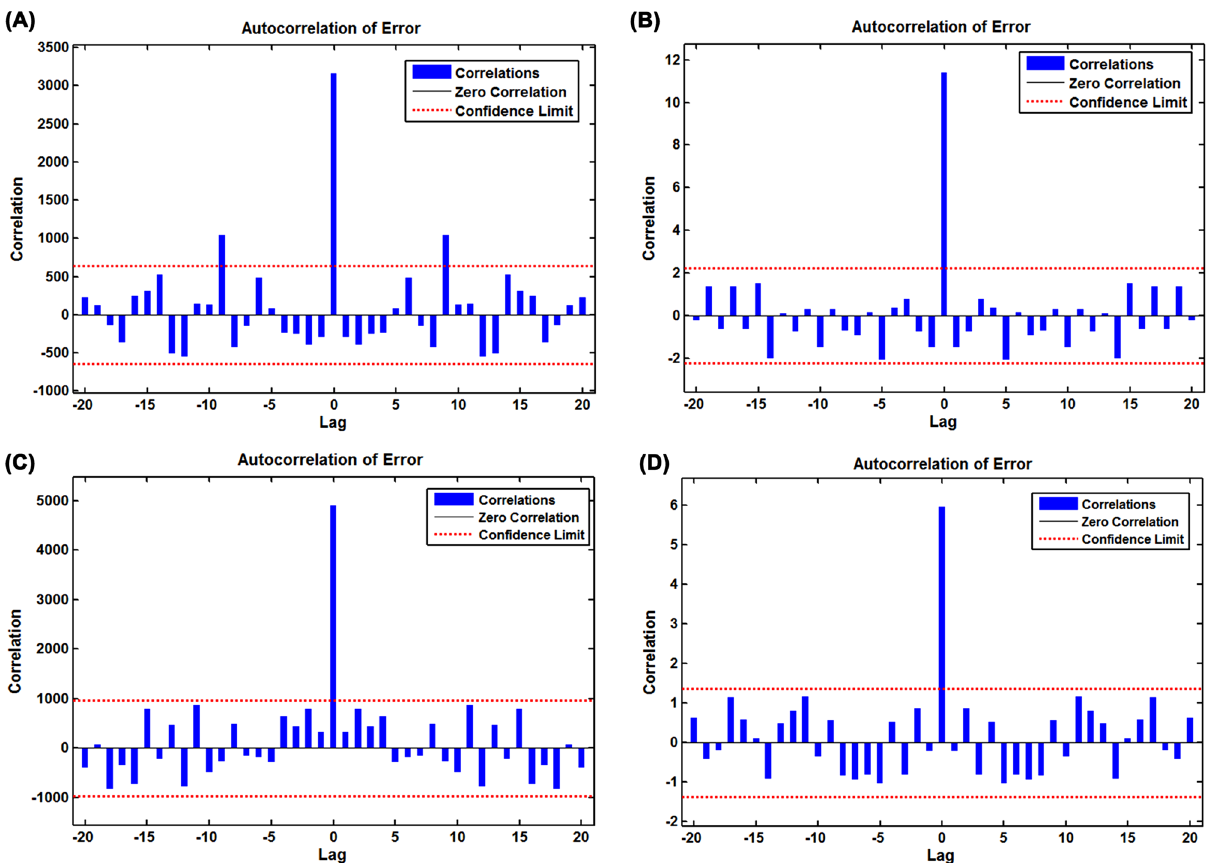
Figure 4. Autocorrelogram (ACF) of the residuals generated by the best NARANN model. ( A ) Sample ACFs of the residuals for the prevalence dada in South Africa; ( B ) Sample ACFs of the residuals for the mortality dada in South Africa; ( C ) Sample ACFs of the residuals for the prevalence dada in Nigeria; ( D ) Sample ACFs of the residuals for the mortality dada in